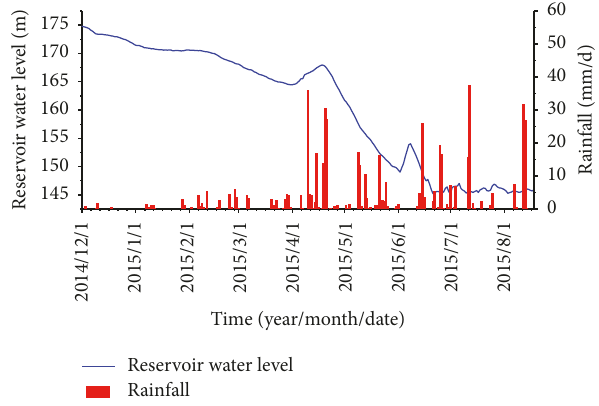
Figure 6: Process of rainfall and reservoir water level variation from December 1, 2014, to August 18,